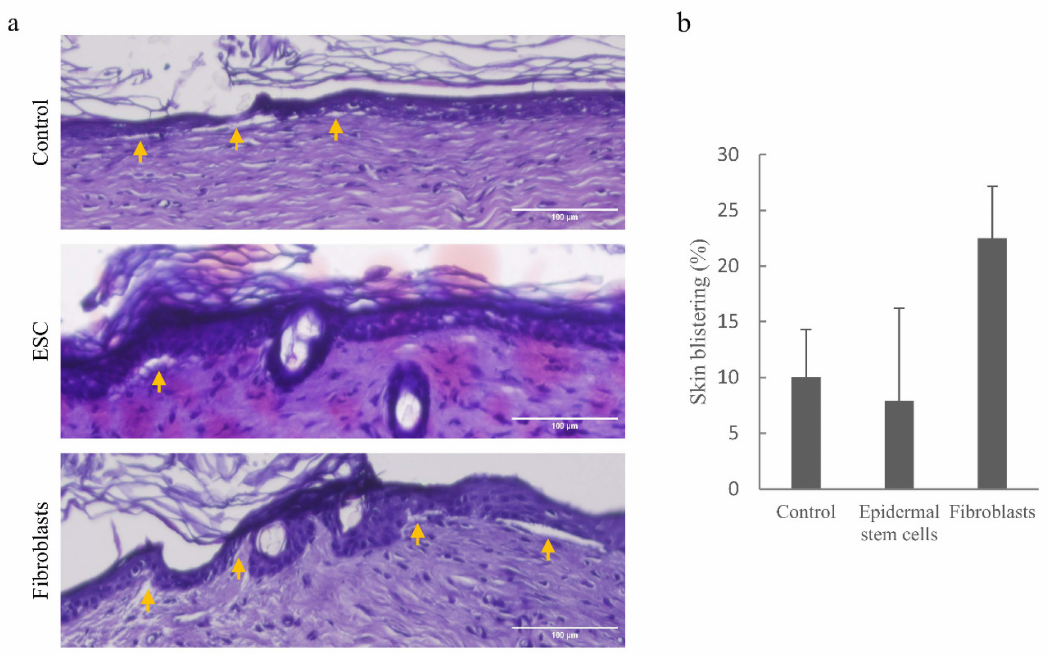
Figure 6. Implantation of wild-type epidermal stem cells or fibroblasts into DDEB rat skin. ( a ) Histo- logical analysis of DDEB rat skin shows skin blistering in control tissue and treated tissues following implantation of wild-type epidermal stem cells (ESC) and fibroblasts. Yellow arrows point to skin blisters on the dermal-epidermal basement membrane. Scale bar is 100 µ m. ( b ) The graph repre- sents the percentage of skin blistering prior to and following the treatment. Error bars represent mean ± standard deviation for 3–4 analyzed slides per